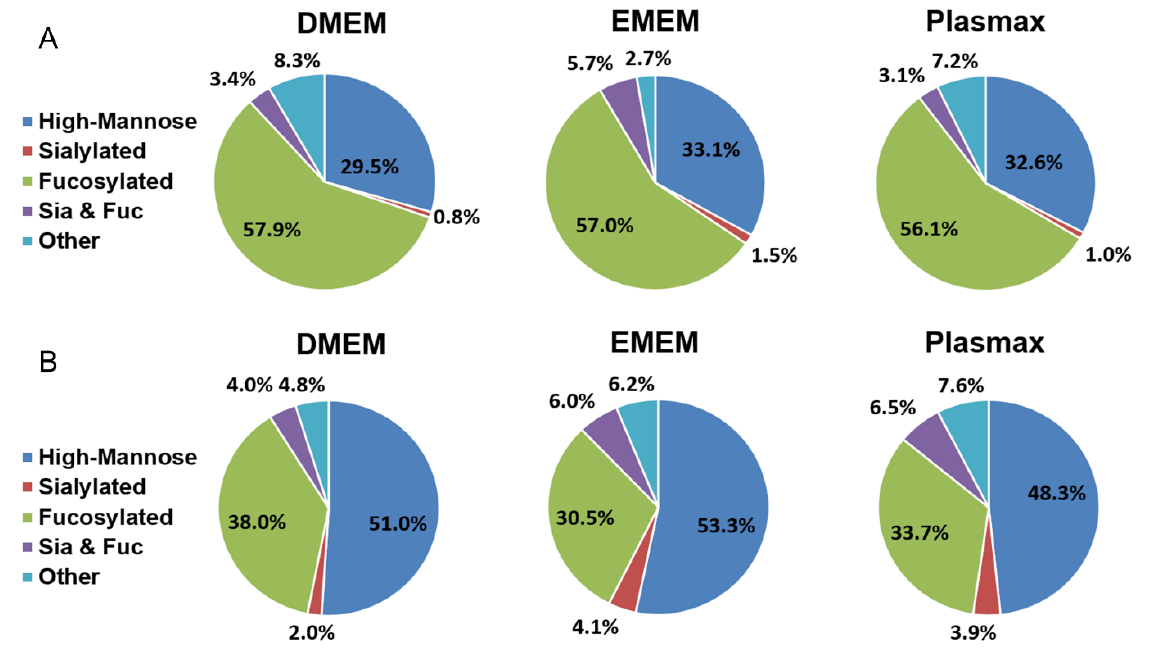
Figure 3. Distribution comparison of different types of N -glycans derived from ( A ) the 231BR cell line and ( B ) CRL cell line cultivated in DMEM, EMEM, and Plasmax. Table 1. Expression discrepancies of different types of N -glycans derived from 231BR and CRL cell lines in three media. The numbers in brackets are standard deviations ( n = 3). p -values were calculated using Student’s t -tests to indicate the significant level of